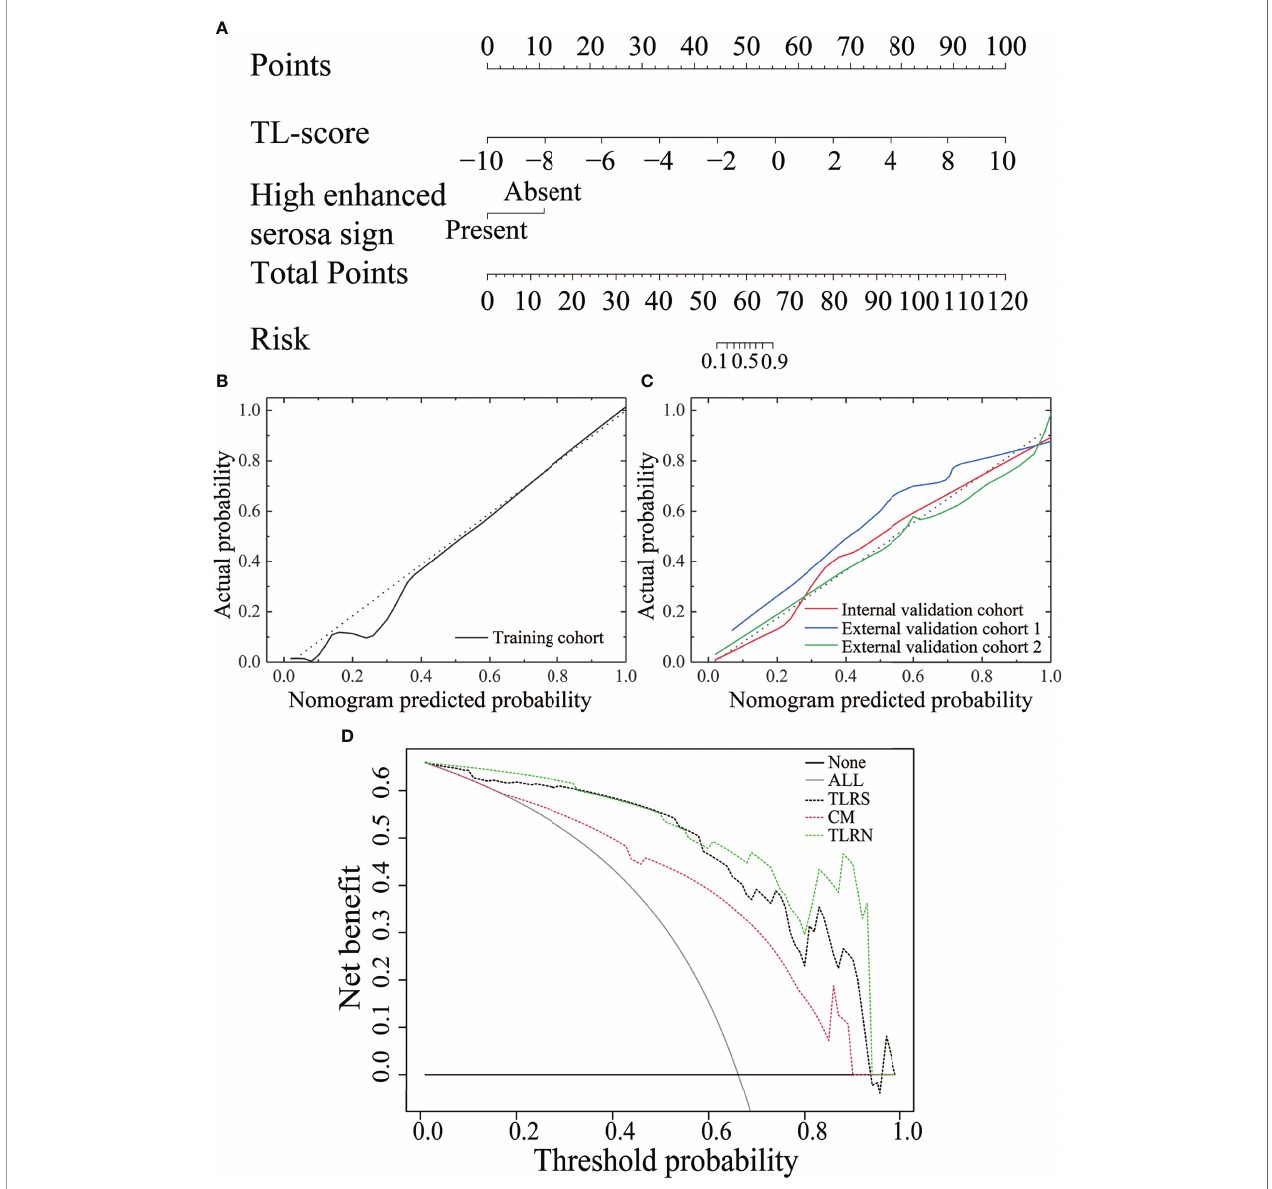
FIGURE 4 | The performance of the transfer learning radiomics nomogram and curve analysis for the various models. (A) The TLRN is based on TLRS and CT subjective fi ndings. Calibration curves of the TLRN in the training cohort (B) and three validation cohorts (C) . (D) Decision curve analysis for various